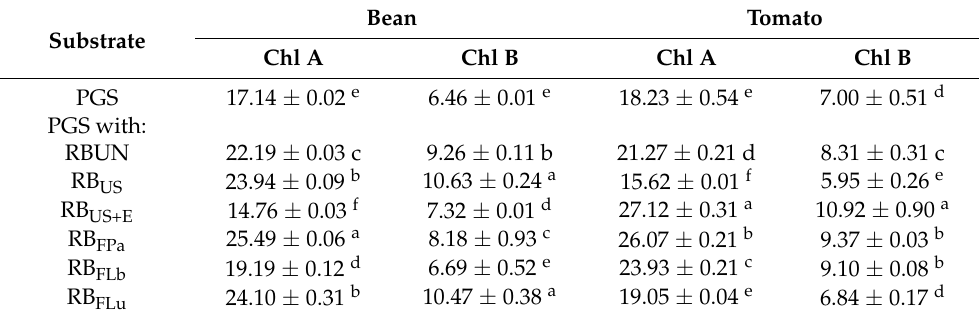
Table 5. Chlorophyll (Chl) concentrations (mg/100 g) in bean and tomato leaves after 42 days of growth in PGS supplemented (10%, w / w ) with functionalized rice bran (RB). Bean Tomato Substrate Chl A Chl B Chl A Chl